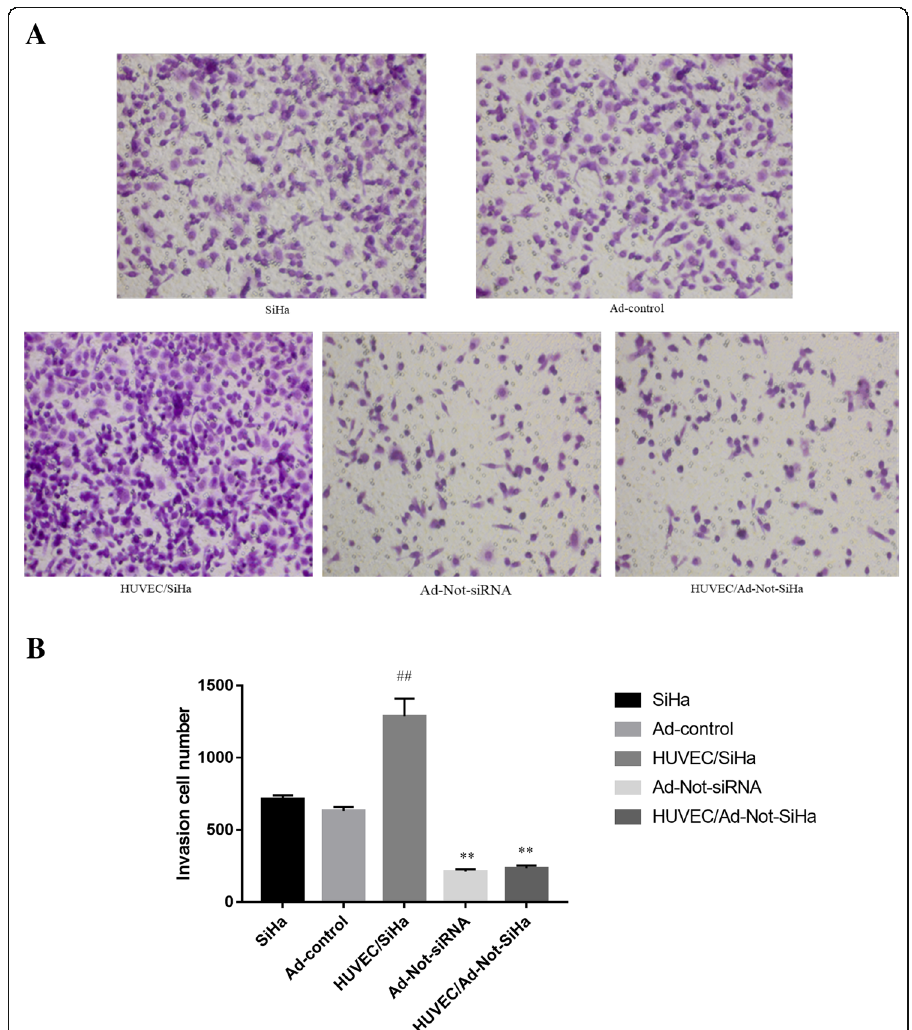
HUVEC/SiHa group, ** P <